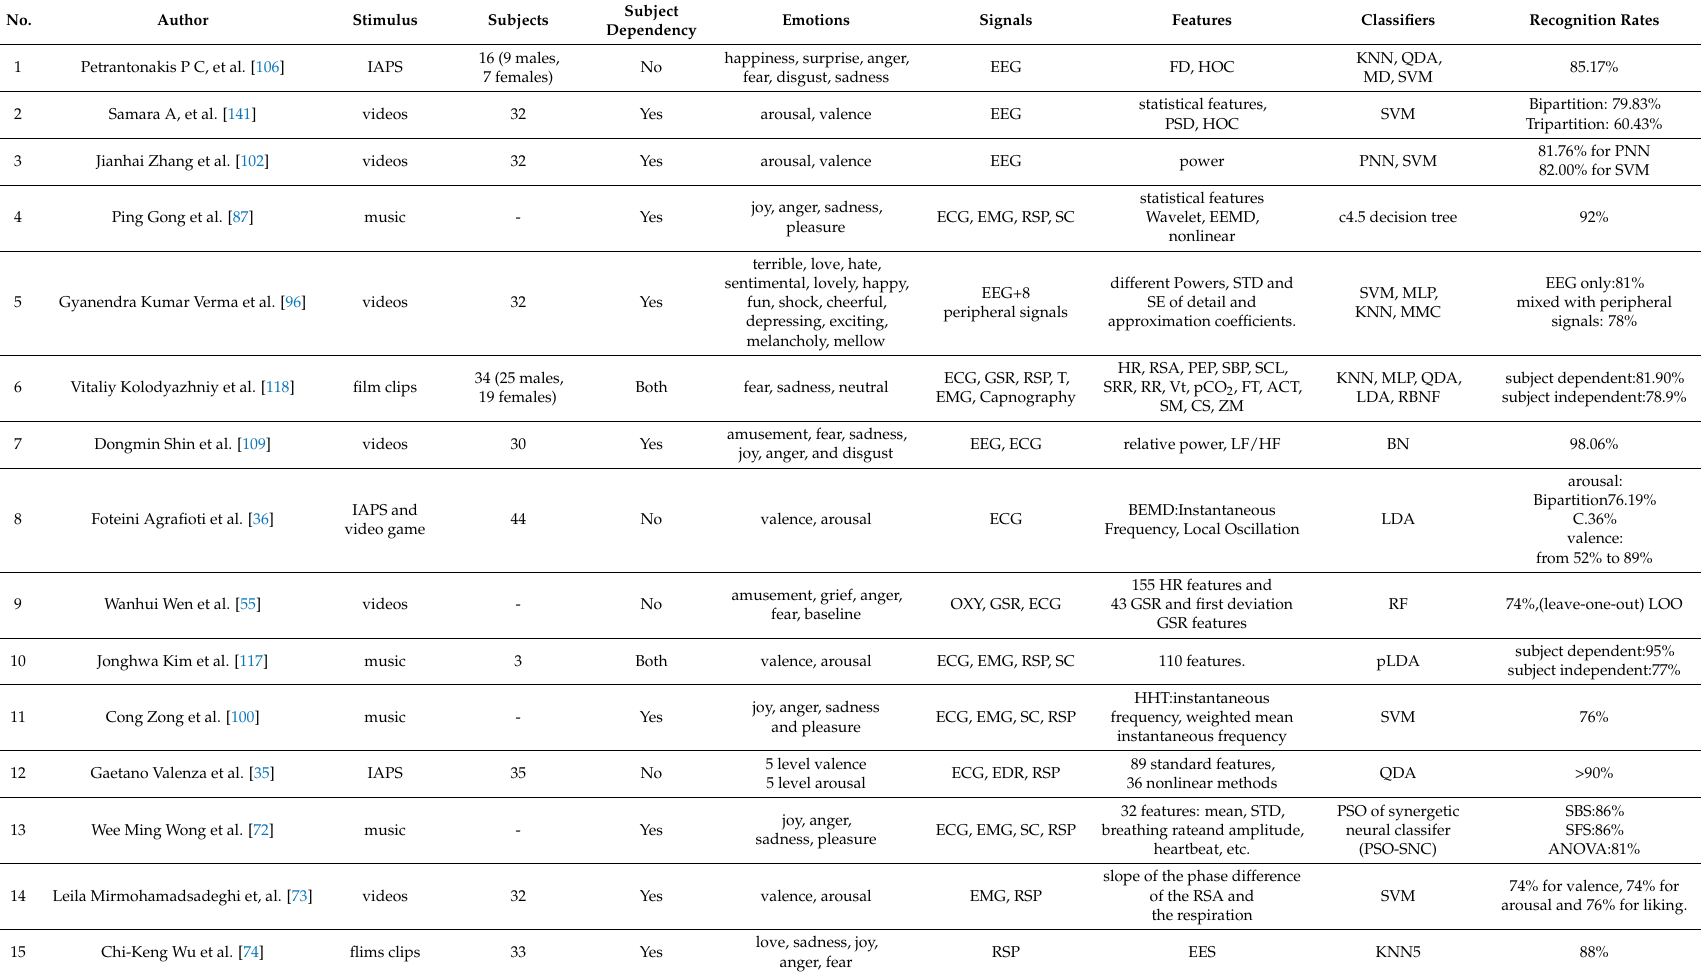
Table 3. Summary of previous